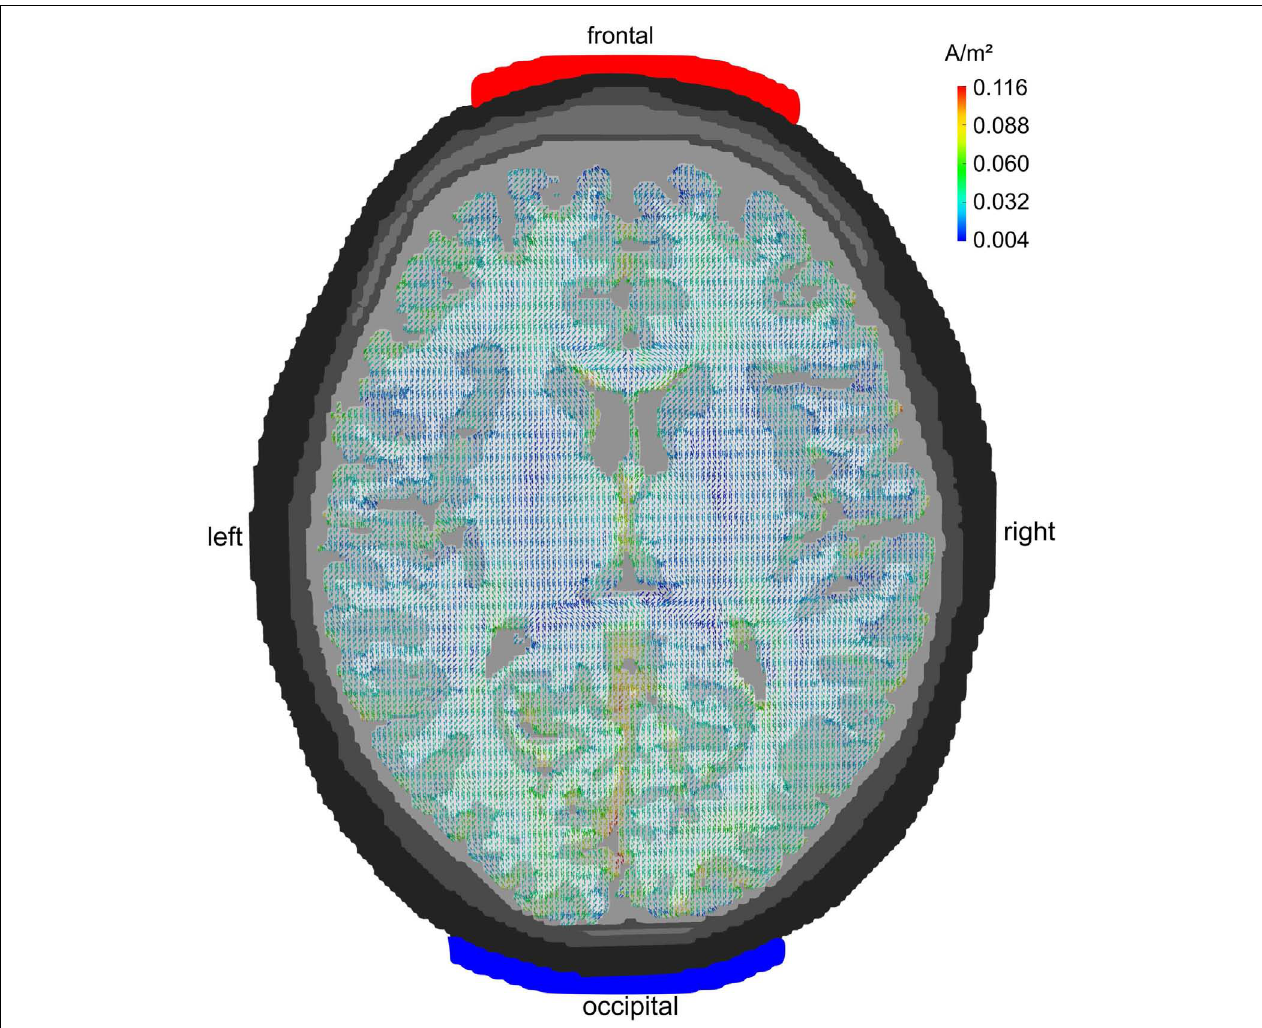
FIGURE 2 | Midline configuration FPz/Oz: axial view. Stimulation electrodes are centered around electrode positions FPz and Oz.The current density is not very focal but rather widespread. All cortical lobes show current densities above 0.07A/m 2 .The maximum current flow is in the occipital